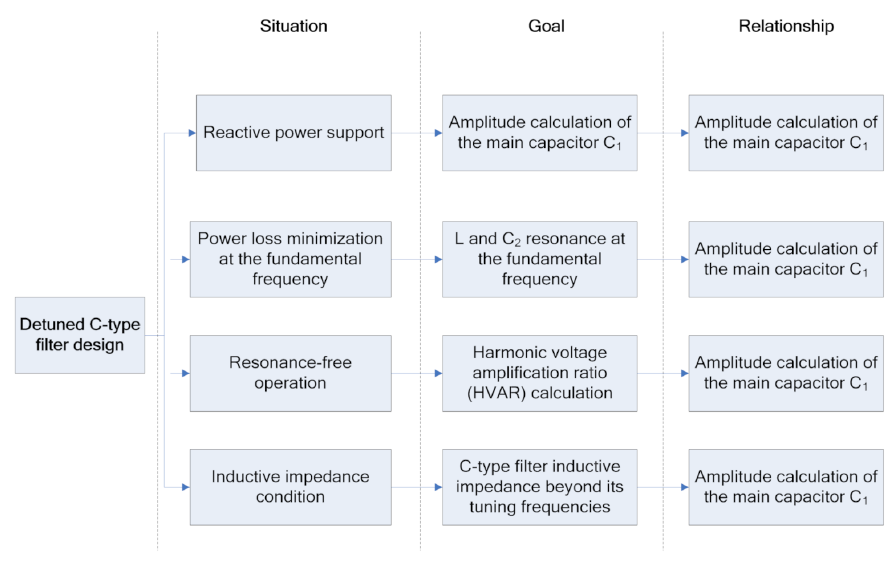
Figure 2. The CTF design